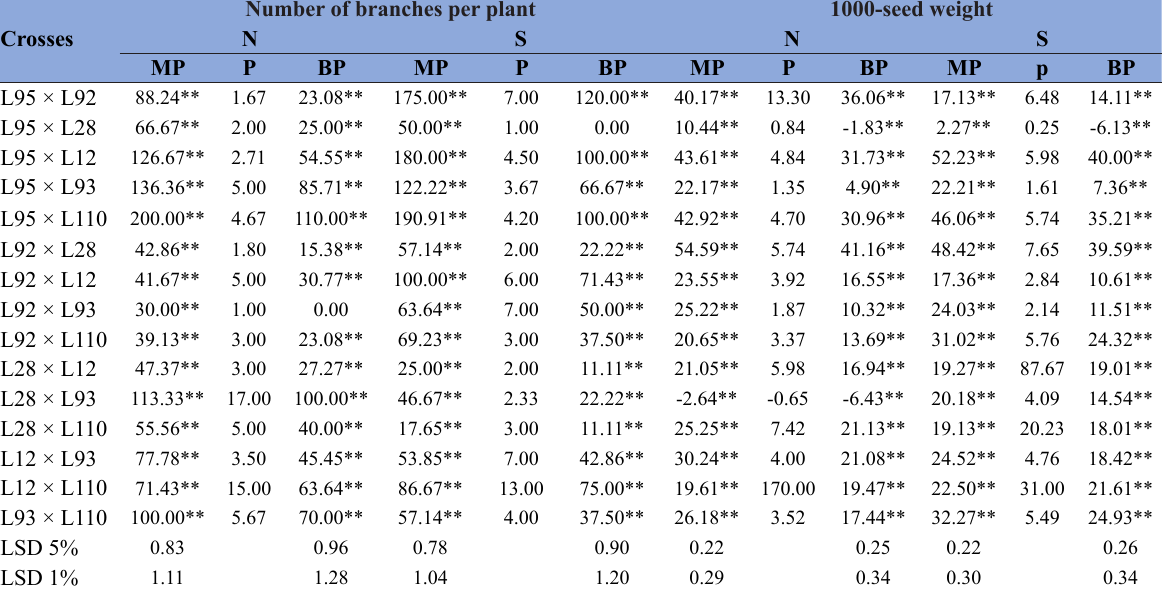
Table 10c. Relative heterosis (MP) and heterbeltiosis (BP) as well as potence ratio (P) of 15 F branches per plant and 1000-seed weight under normal irrigation (N) and water stress conditions (S) in 2019 season